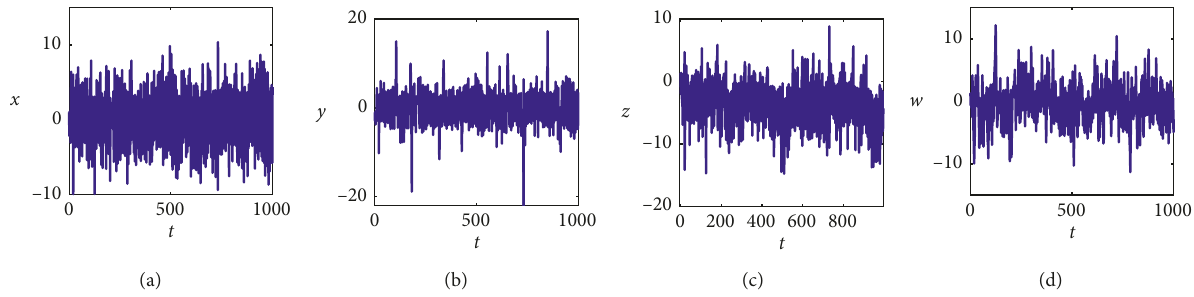
Figure 2: The time variation of state equations x,y, z, and w of system (2): (a) t − x , (b) t − y , (c) t − z , and (d) t − w . –1–0.500.5